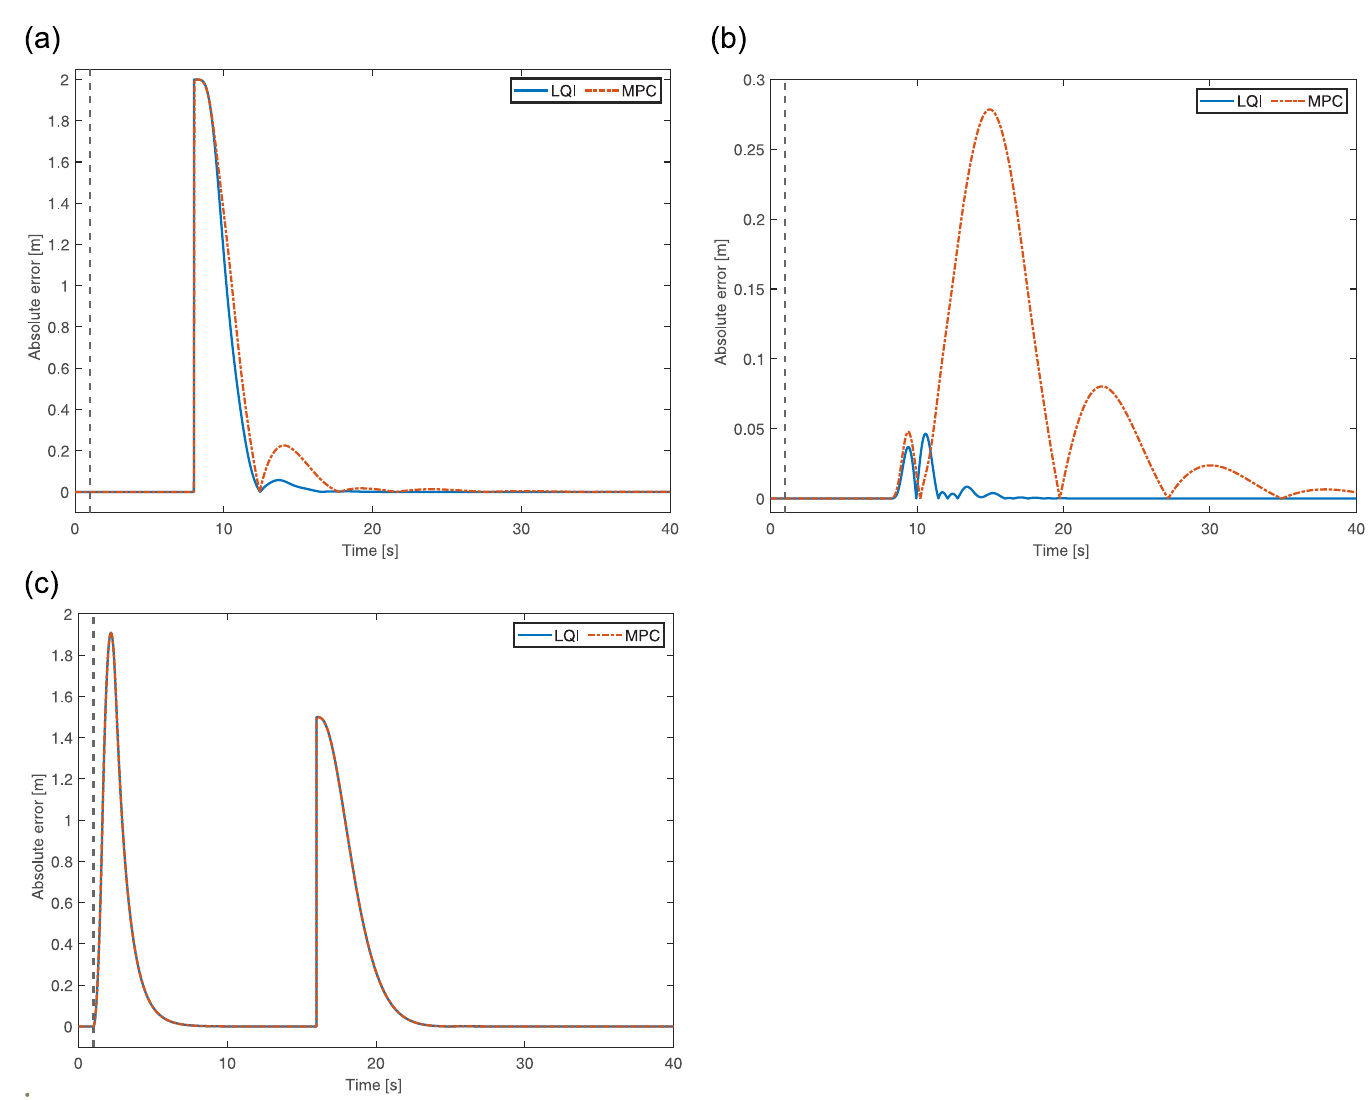
Fig 7. 3D position error of the quadrotor for Two opposing propellers’ failure. (a) Error in X-axis. (b) Error in Y-axis. (c) Error in Z-axis.